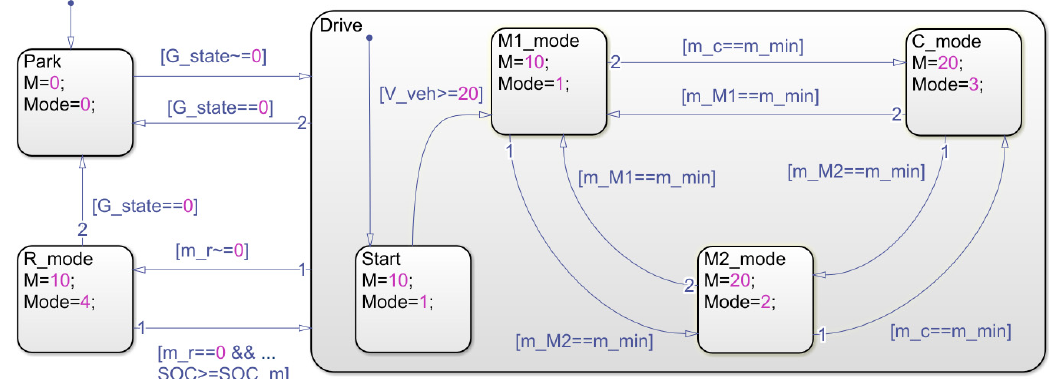
Figure 13. The state flow chart of mode definition control. G_state: the state of gear; m_M1: mass flow rate of Motor 1; m_M2: mass flow rate of Motor 2; m_min: minimum mass flow rate; m_c: mass flow rate of compound mode; m_r: mass flow rate of the regenerative braking mode.